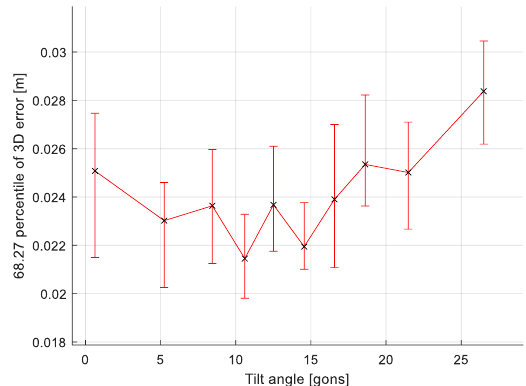
Figure 8. 3D error as a function of the tilt angle; more precisely, the 68.27 th percentile is shows, of 3D error, as explained in the text.